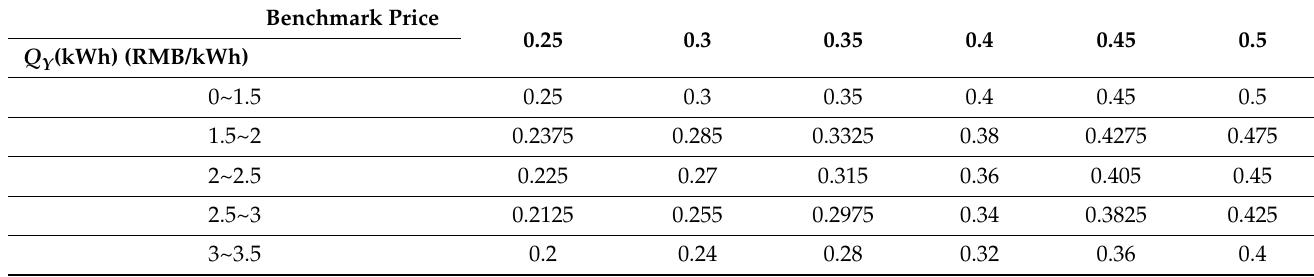
Table 3. Medium- and long-term transaction prices with different benchmark prices. Benchmark Price